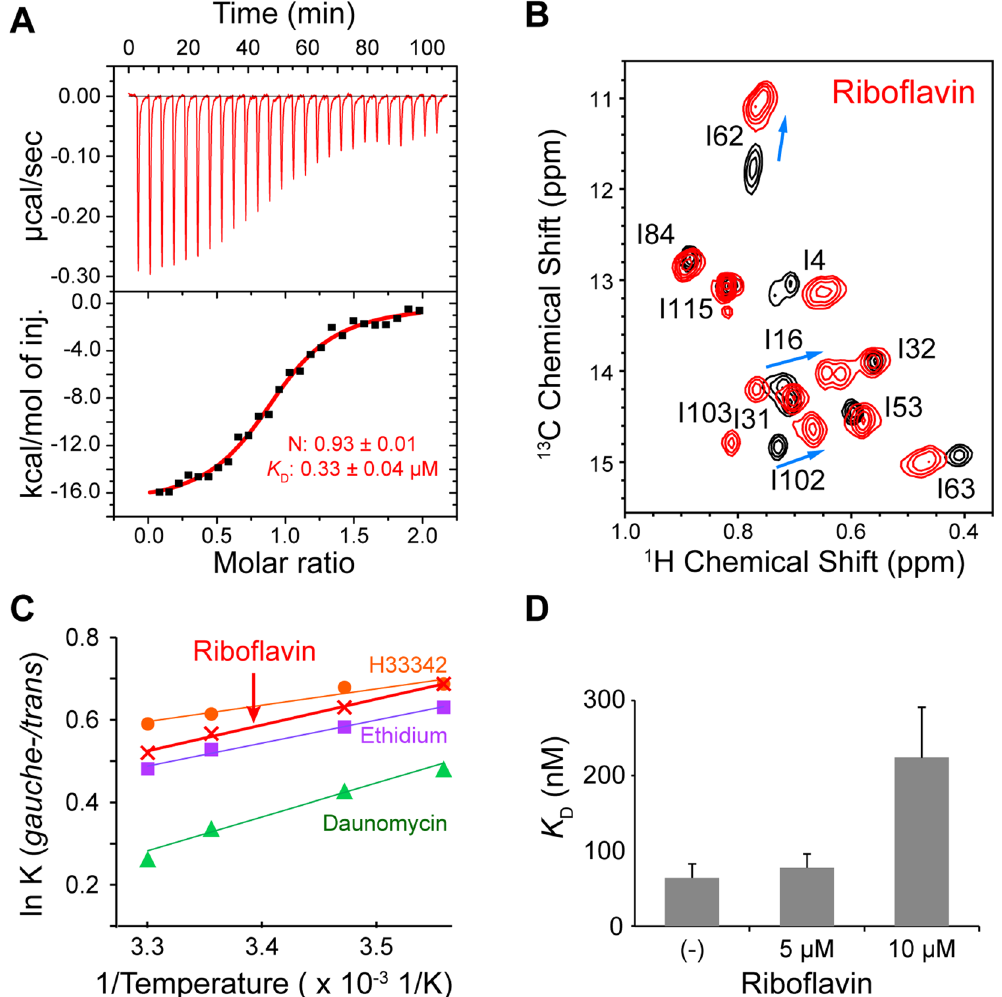
Figure 3. Effect of riboflavin ligation on the LmrR conformation and the LmrR-DNA interaction. ( A ) ITC measurements of the interaction between LmrR and riboflavin. Riboflavin was titrated against LmrR. ( B ) The Ile 1 H δ 1 - 13 C δ 1 resonances of LmrR in the apo state (black) were overlaid with the riboflavin-bound state resonances (red). ( C ) van’t Hoff plot for the Ile 62 χ 2 angle rotameric equilibrium in the compound-bound states. The Ile 62 δ 1 13 C chemical shifts were used to calculate the population of each conformer, assuming the exchange between the gauche- and trans rotameric states 20 . ( D ) Riboflavin ligation to LmrR reduces its binding affinity to the lmrCD operator. Data are representative of two independent